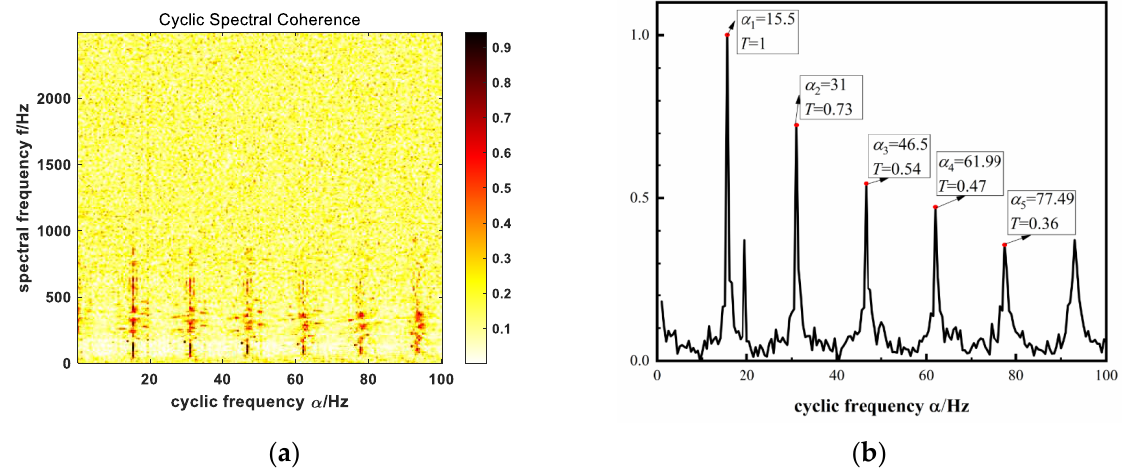
Figure 8. ( a ) The cyclic spectrum coherence function graph of the Robinson R44 helicopter at 3.568 km; ( b ) the cyclic frequency detection results of the Robinson R44 helicopter at 3.568 km.